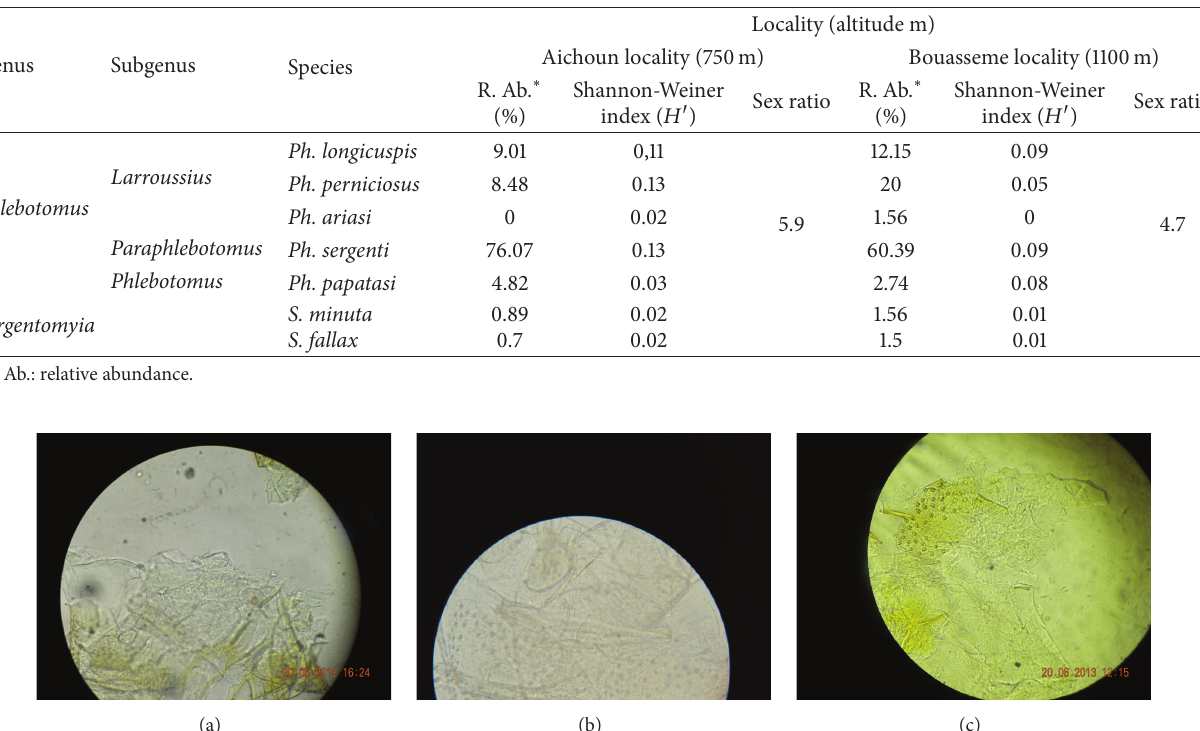
Table 1: Percentage and the Shannon-Weiner diversity index ( 𝐻 ) of the sand flies collected during the study period at both localities of the Fes-Boulemane region.